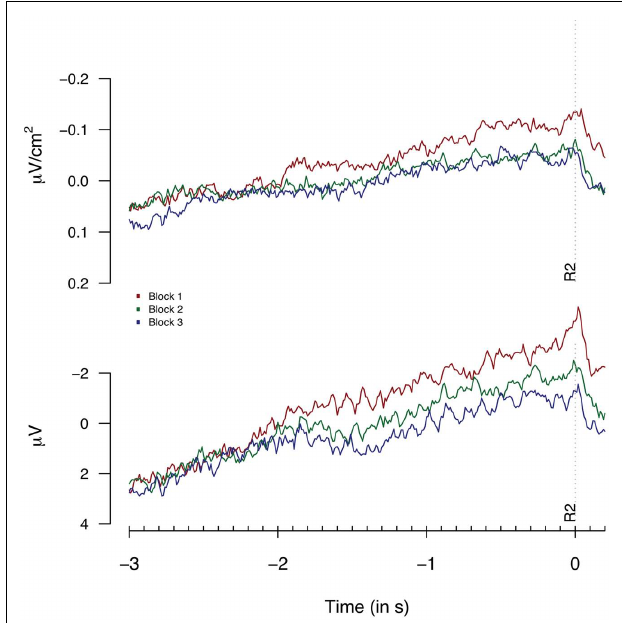
FIGURE 4 | Second response (R2) locked Laplacians (top graph, means based on 9 “3-in-a-row” participants) and monopolar recordings (bottom graph, means based on 17 participants) obtained at FCz during Experiment 1, plotted separately for the first, second, and third 33% of all trials.